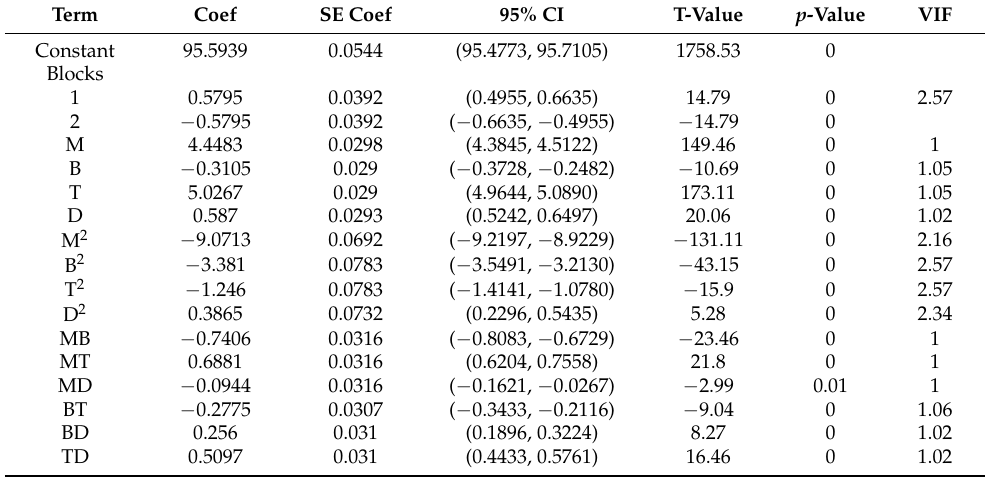
Table 16. Coefficients of the regression fit and VIF values for the transesterification process of